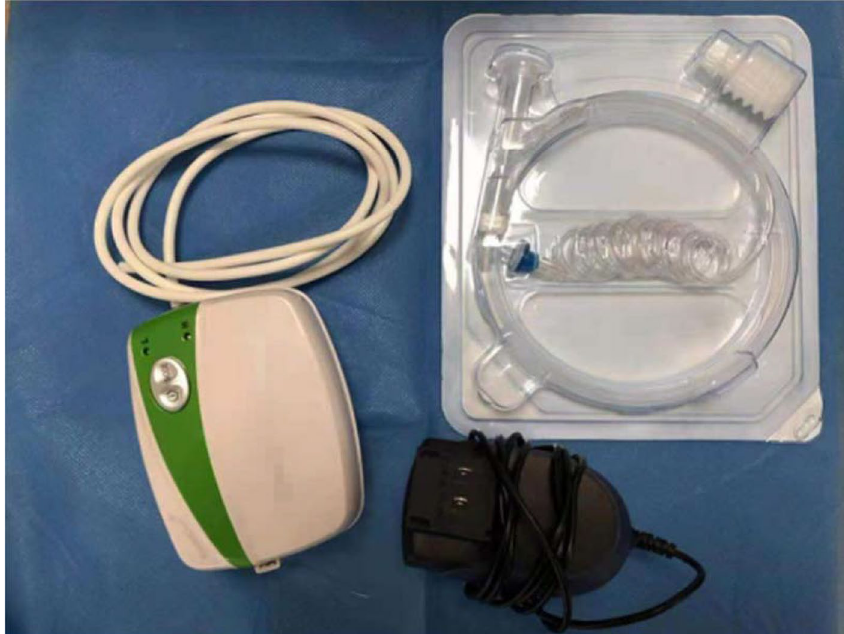
Figure 1. Photograph of the PEO application devices. 1 PEO polyethylene